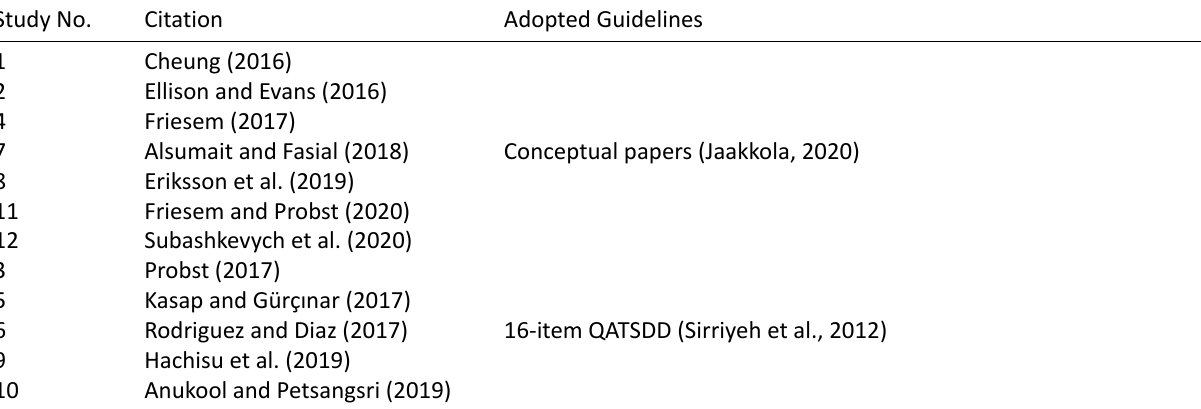
Table 1. Studies’ characteristics regarding the sample and the adopted research design ( N = 12). Study